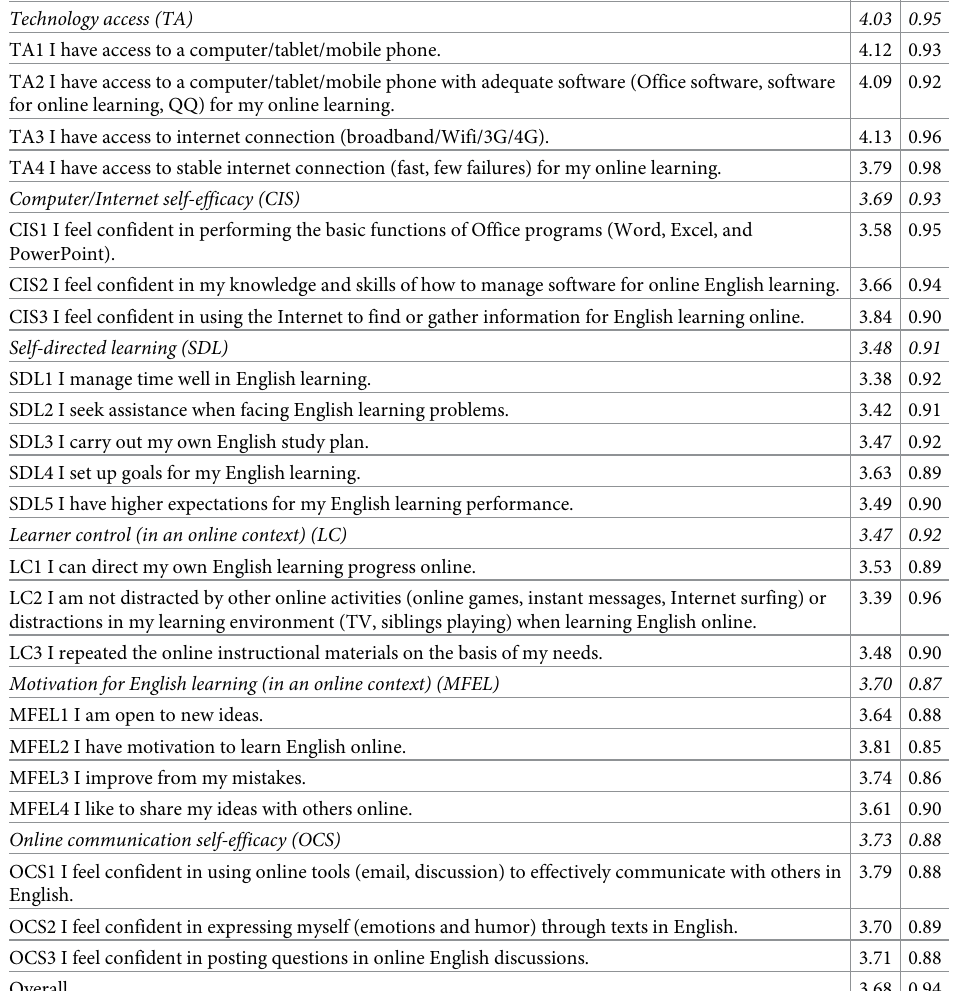
Table 3. Means (M) and Standard Deviations (SD) of the SRS (N = 2310). Dimensions & items M SD Technology access